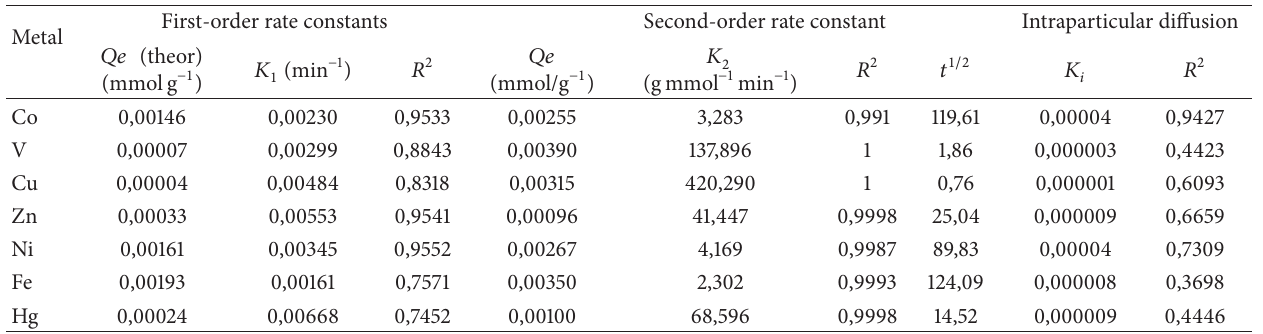
Table 3: Adsorption kinetics of metals in multielement mixture at pH = 4.